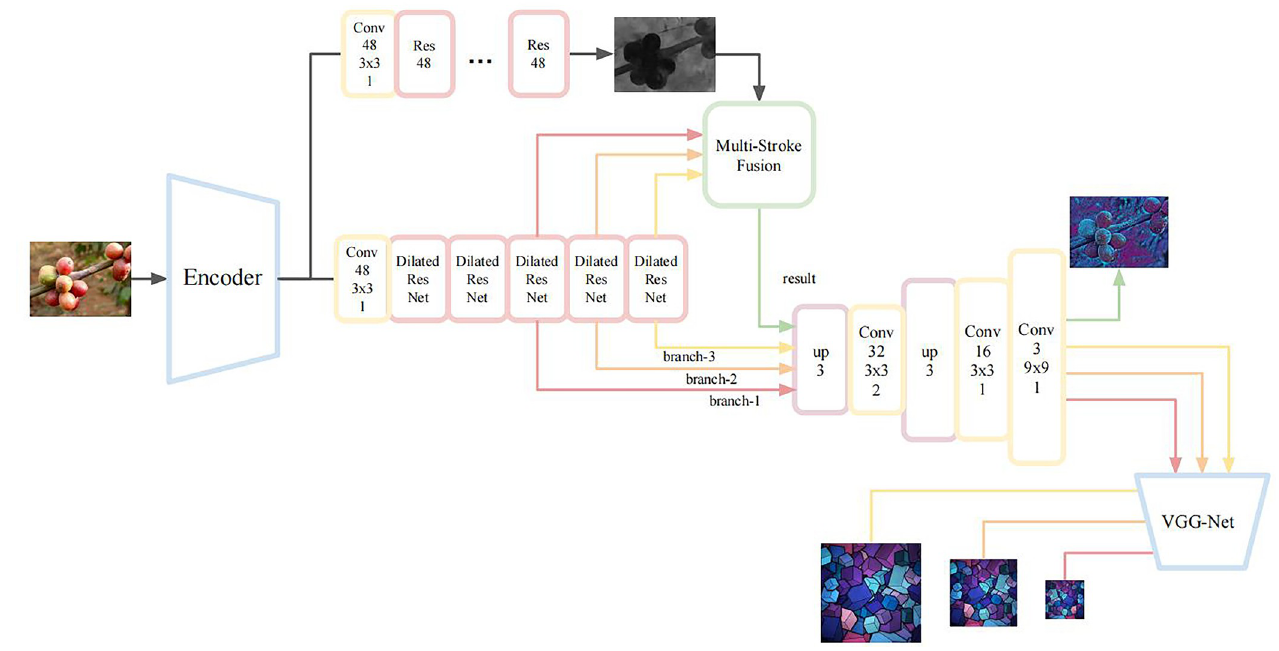
Fig 3. Defocusing adaptive multi-stroke network